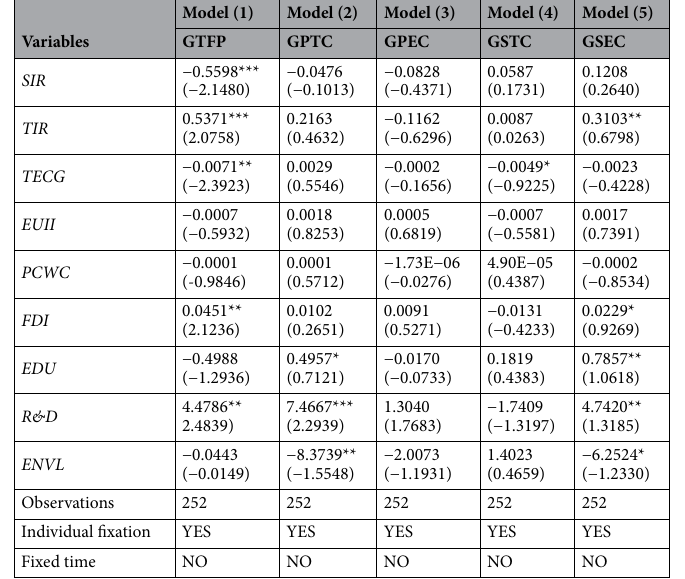
Table 3. Estimation results of factors affecting changes in green total factor productivity. ***, **, *respectively represent the significance level of 1%, 5%, and 10%, and the standard deviation of cluster robustness is in parentheses, and Observations represent the number of